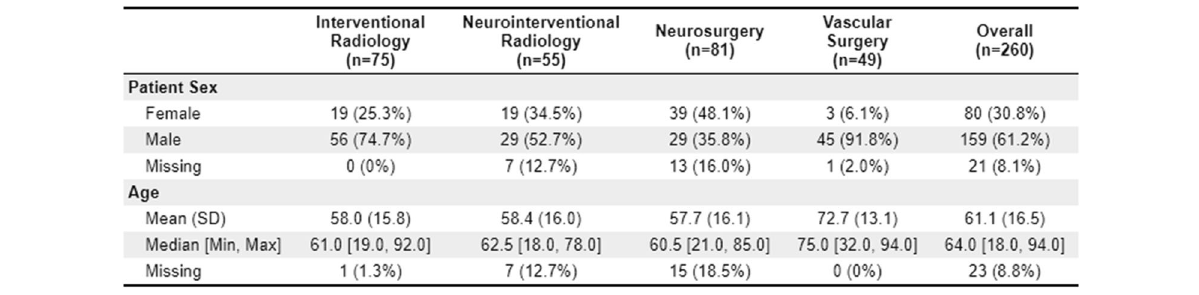
Table 1 Patient demographics. Statistical significance level is P < 0.05. (SD = standard